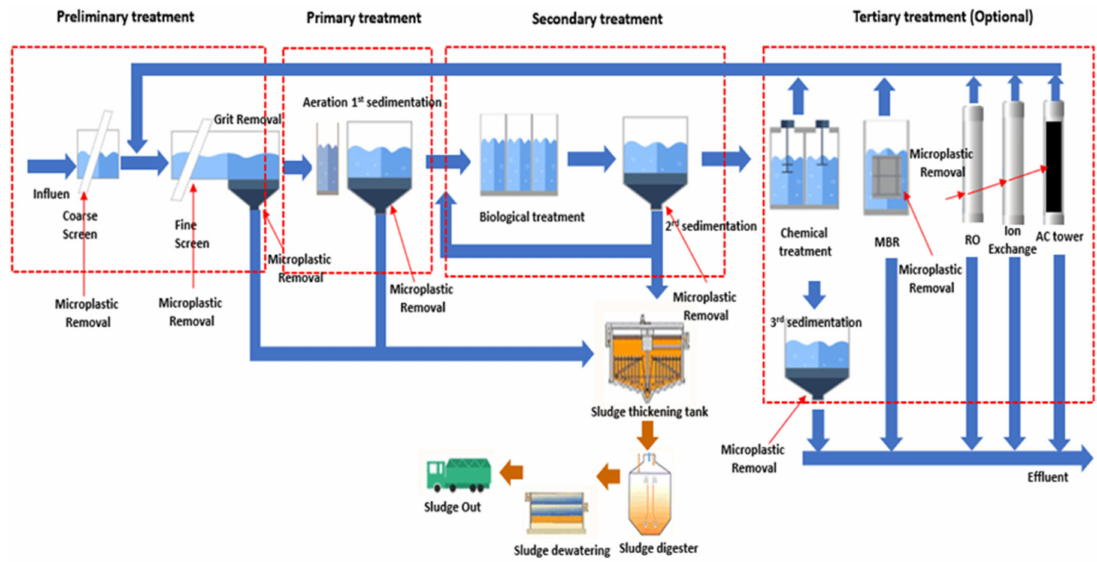
Figure 8. Microplastic-removal process in